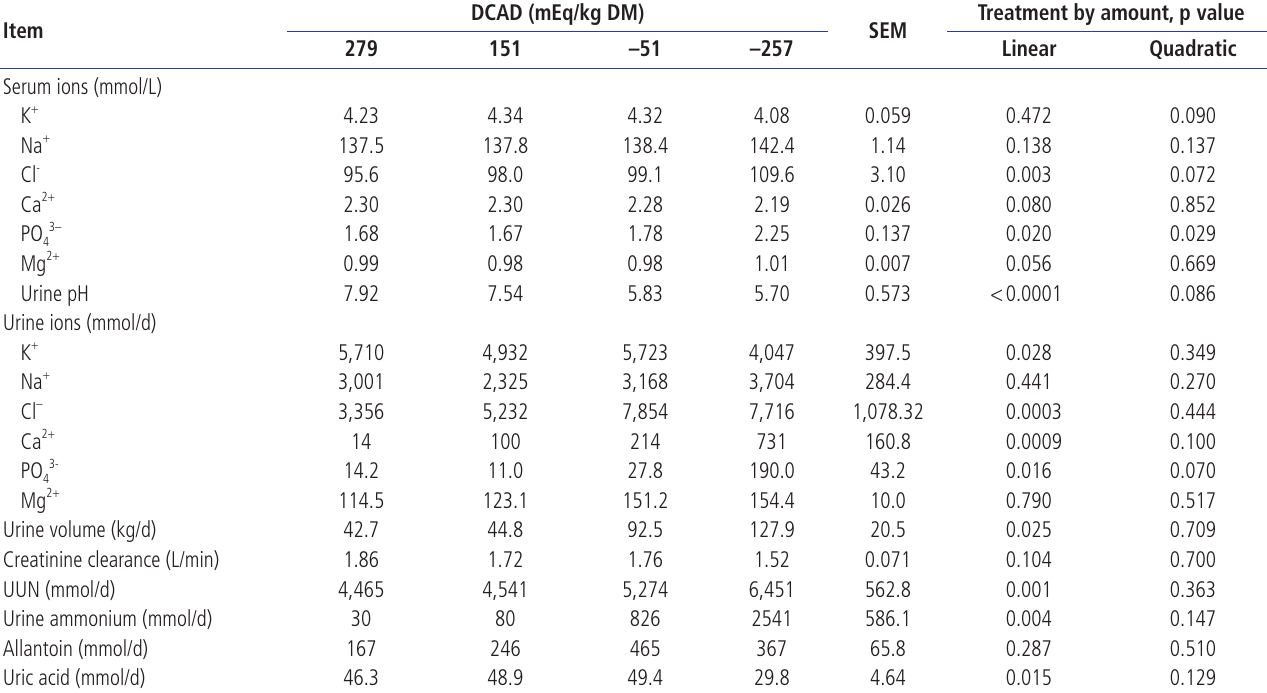
Table 4. Effects of low DCAD on serum ions, urine irons and urine metabolites of lacating dairy cows